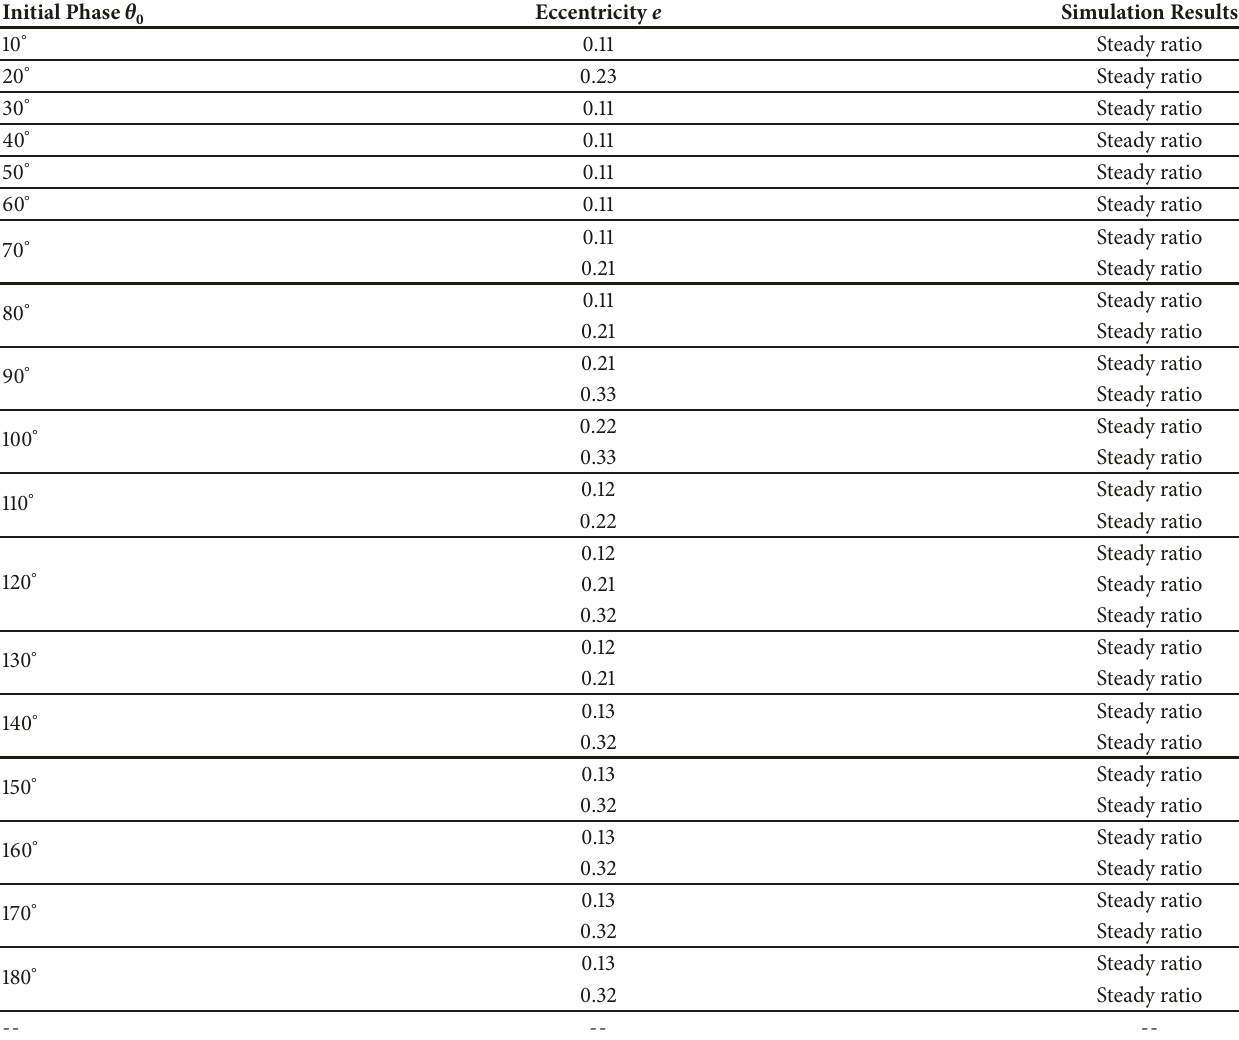
Table 4: Simulation results for 1:2 resonant orbits when the initial parameters cause closest distance r 1 > 𝑟 Hill